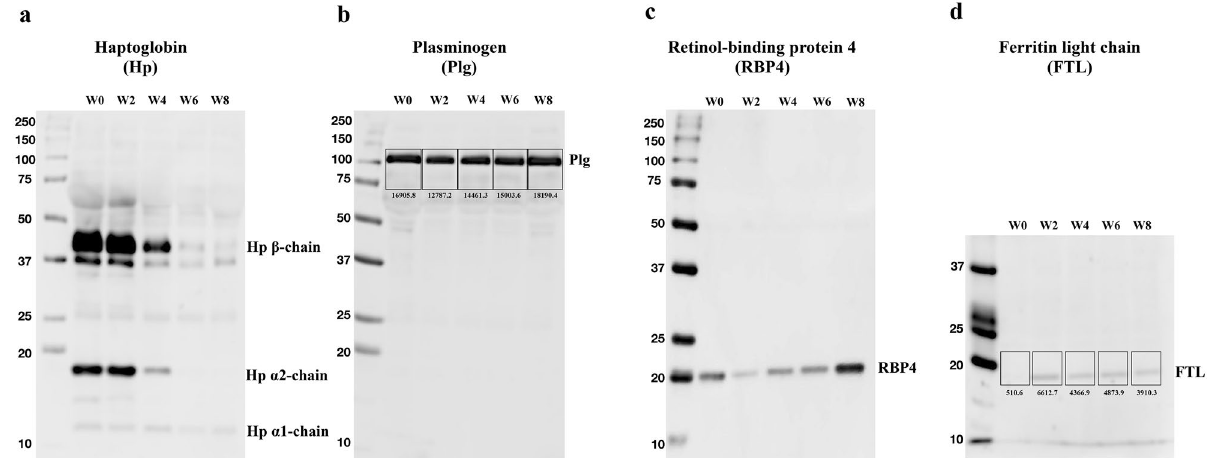
Figure 6. Post-transplant serial changes in four serum proteins from Patient no.1. Serum samples collected over time from patient no.1 were subjected to western blotting analysis. Serum proteins of 10 µg was first separated by 8–12% SDS-PAGE and Precision Plus Protein WesternC Standard (Bio-Rad) was used as protein standard. Proteins were then transferred to a PVDF membrane and stained with antibodies. Primary antibodies were diluted at 2000-fold except for FTL (1000-fold). HRP Goat Anti-Rabbit IgG was used as secondary antibody in 2000-fold dilution except for RBP4 (10,000-fold). Signals of bands were quantified using ImageJ